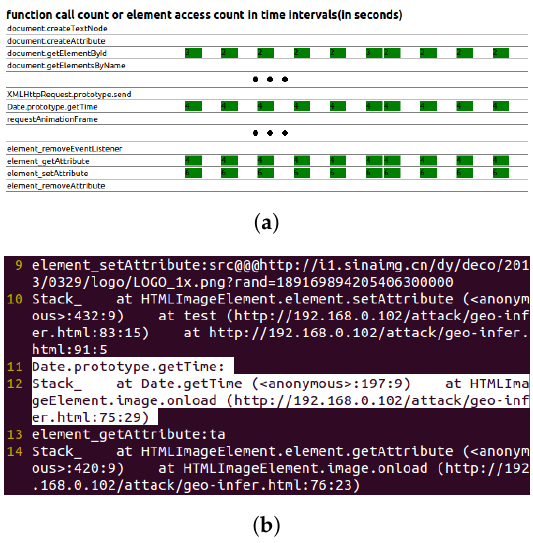
Figure 7. Web caching-based timing probing attack. ( a ) Real-time function call and element access chart; ( b ) behavior log (attack pattern is